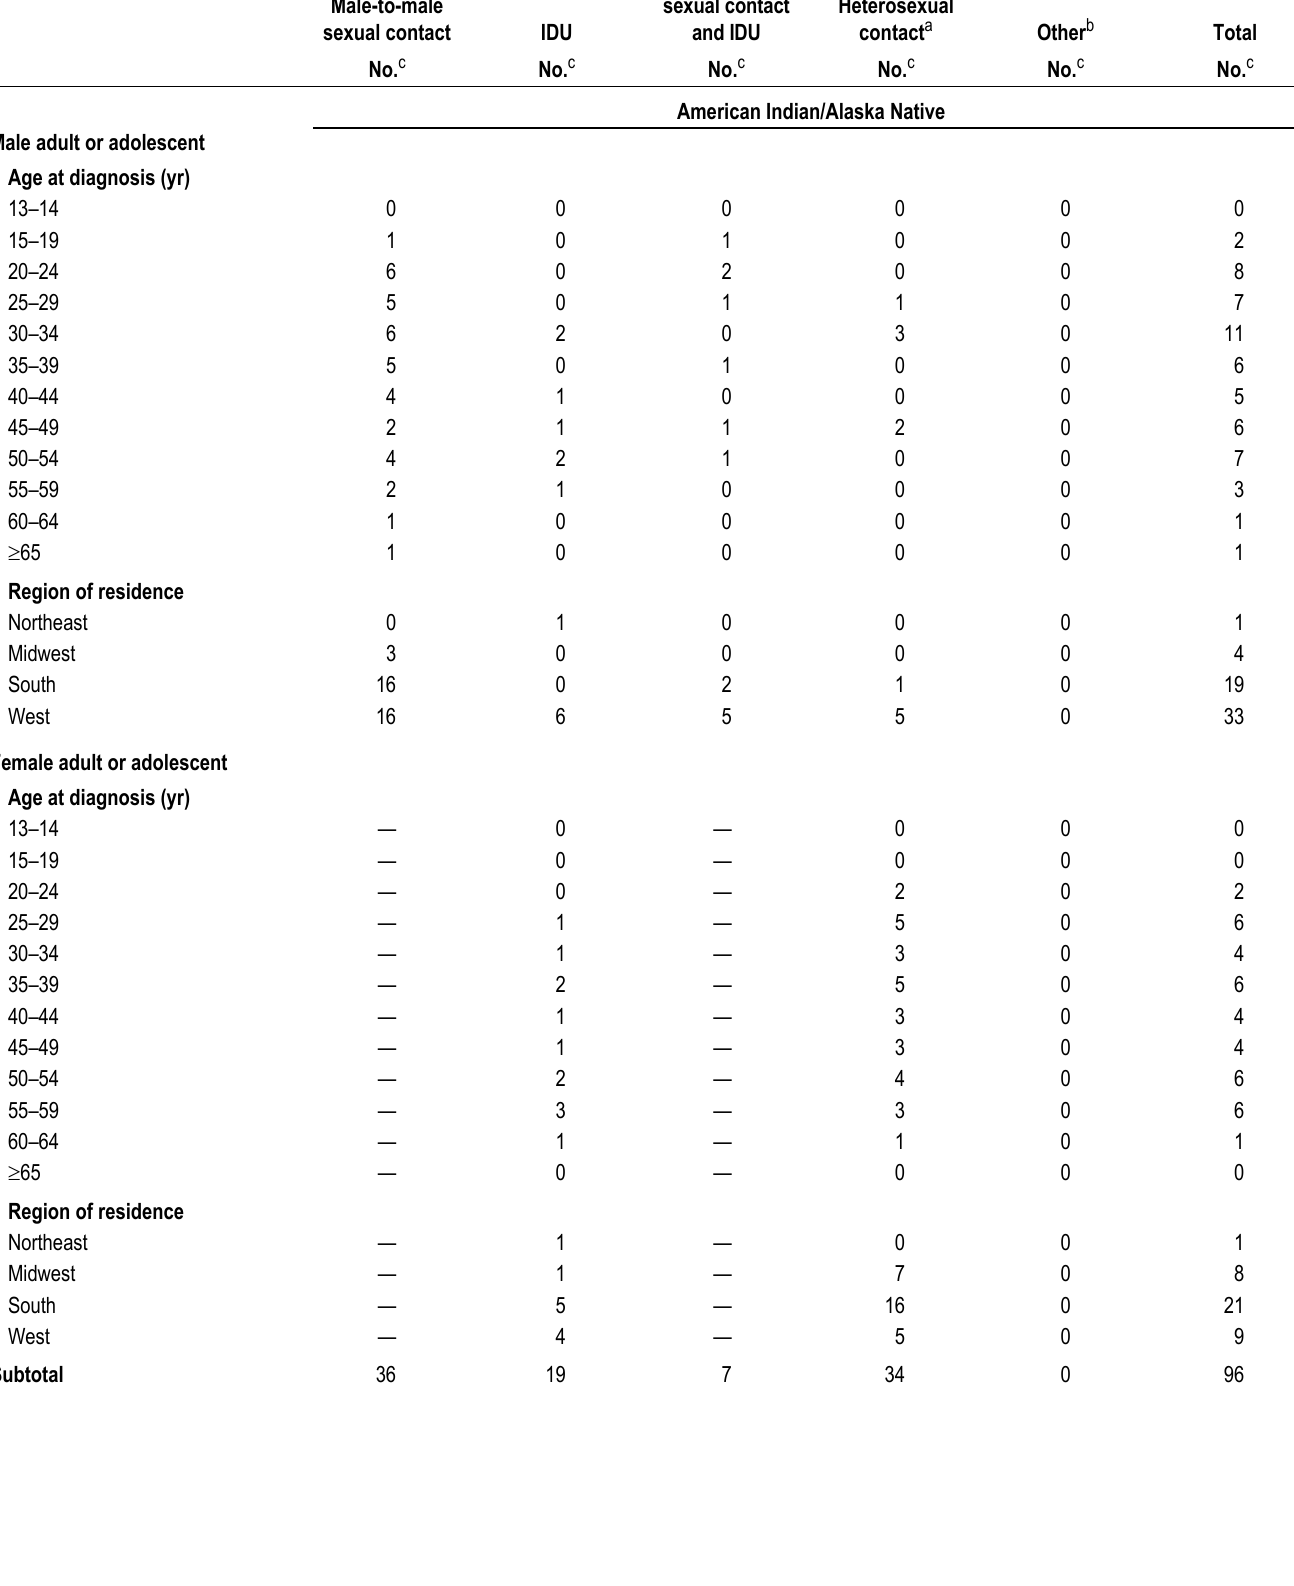
Table 6a. Stage 3 (AIDS), by transmission category, race/ethnicity, and selected characteristics, 2015—United States